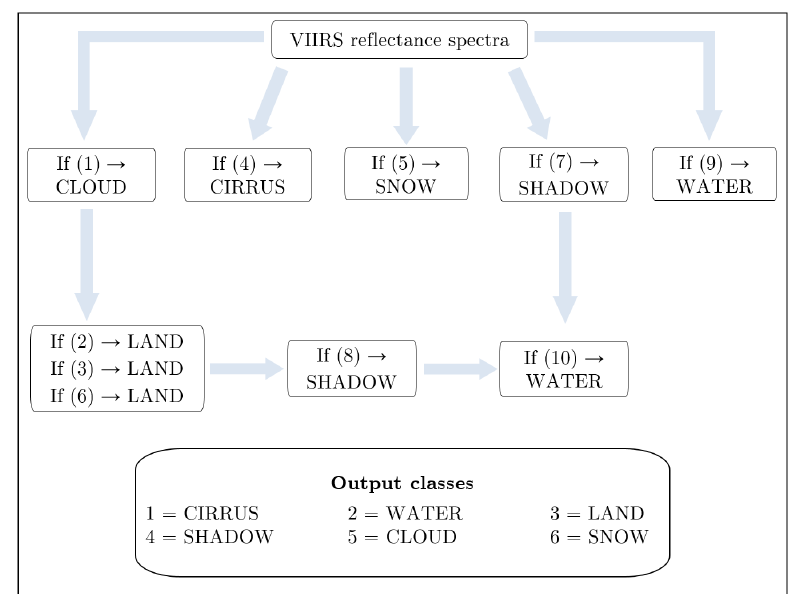
Figure 2. Cloud and shadow detection flow chart. The output mask is initialised to land class (clear pixel). Rules are successively evaluated along the paths shown with blue arrows. When a rule is false, the output class for the pixel remains unchanged. When a rule is true, the output is assigned to the class associated with that rule (after the black arrow → in the corresponding